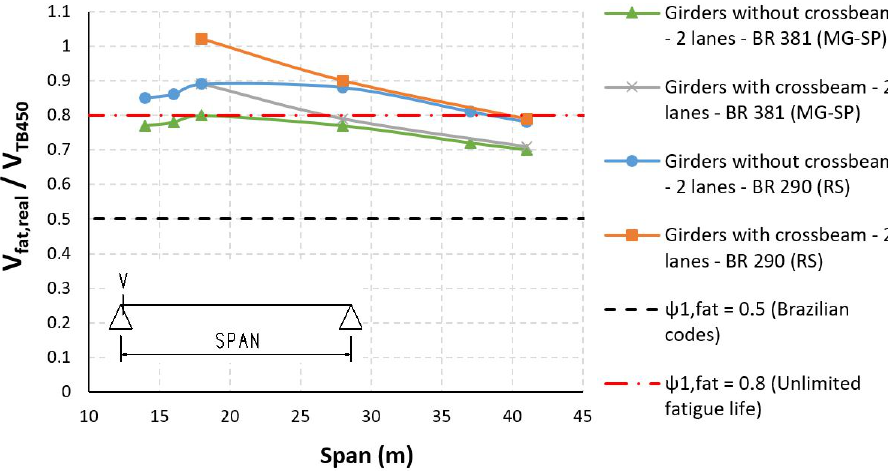
Figure 20. Bias factors for shear force at support in simply supported girder